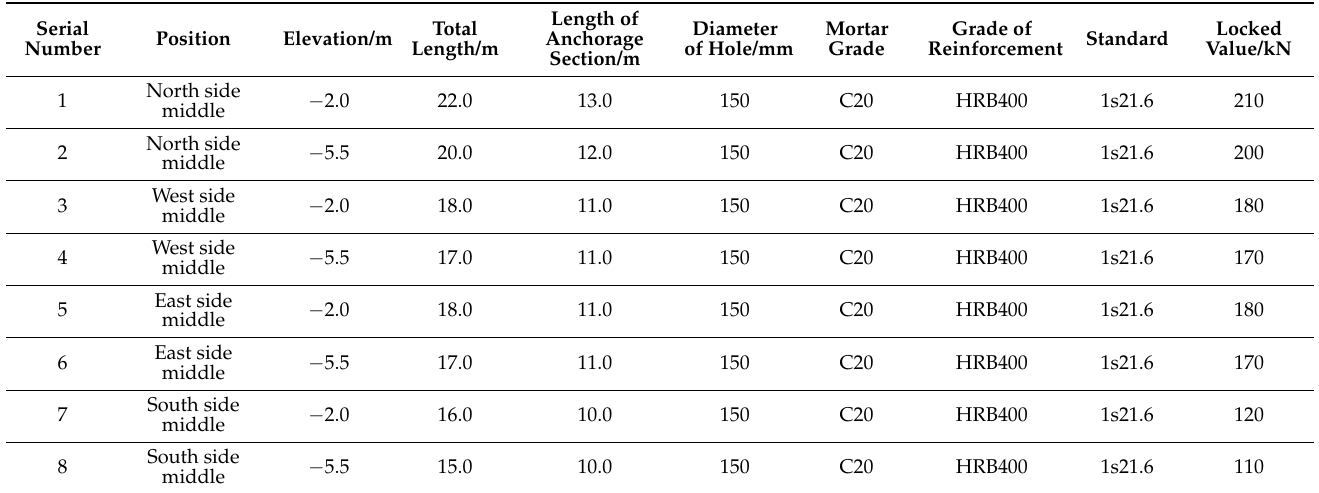
Table 4. The geometric and material parameters of the anchor cables.